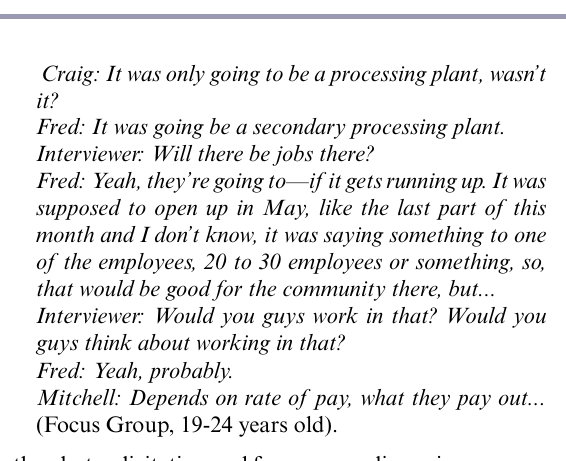
Table 2 . “Fishing is a tough way to make a living” responses. Total number of participants in this analysis = 107. Fishery Experience Strongly Disagree or Disagree Neither Agree nor Disagree Agree or Strongly Agree Lived in a city/town with a fishing industry and worked in a fishing industry (n = 7) Lived in a city/town with a fishing industry (n =